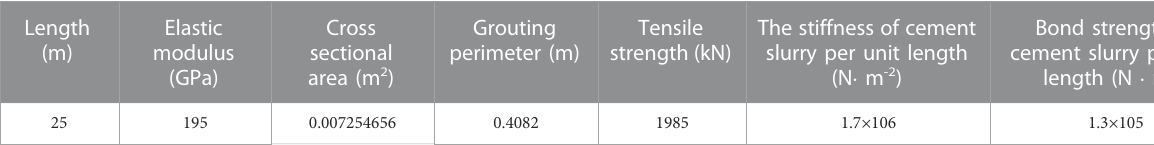
TABLE 4 Parameters of frame beams.